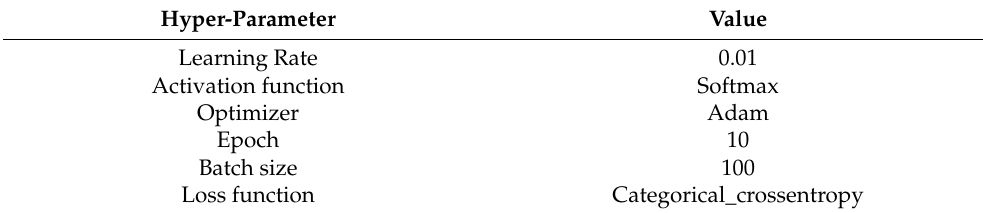
Table 2. Hyper-parameters for experiments with Resnet50.